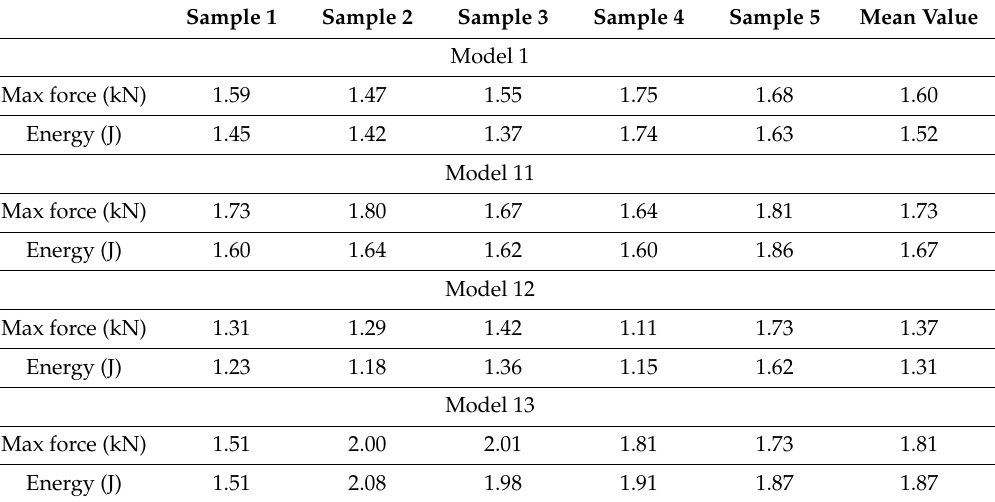
Table 7. Maximum force and energy.